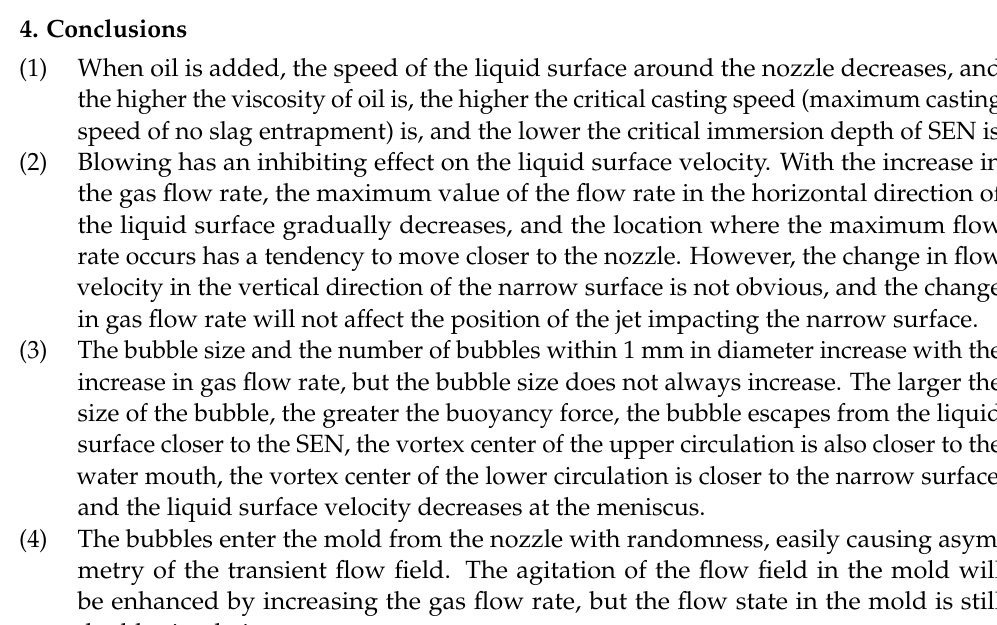
Figure 22. Comparison of flow velocity and velocity at different distances from the narrow surface (gas flow rate is 30 mL·min − 1 ). (gas flow rate is 30 mL · min − 1